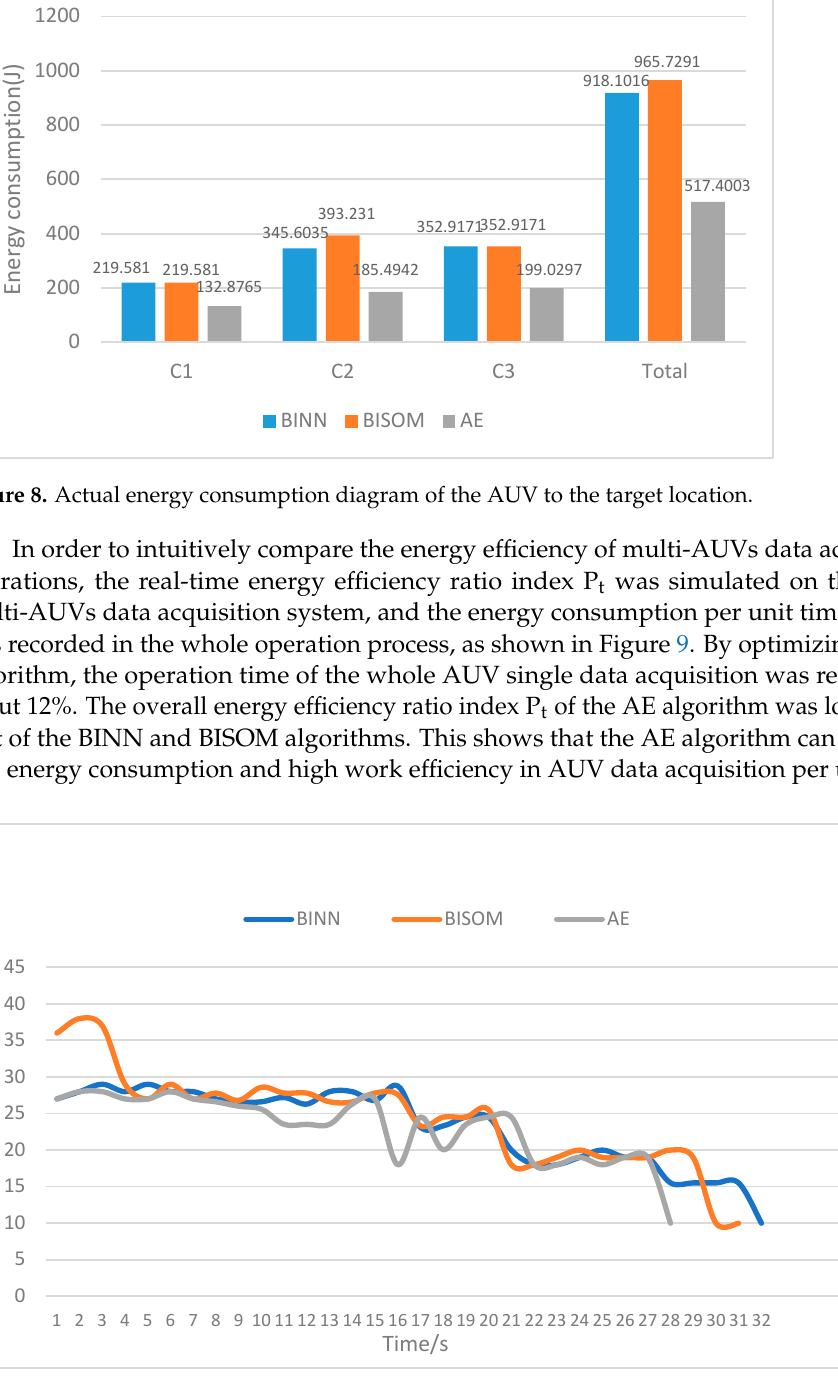
Figure 9. Index diagram of the energy efficiency ratio of multi-AUVs data acquisition operations.